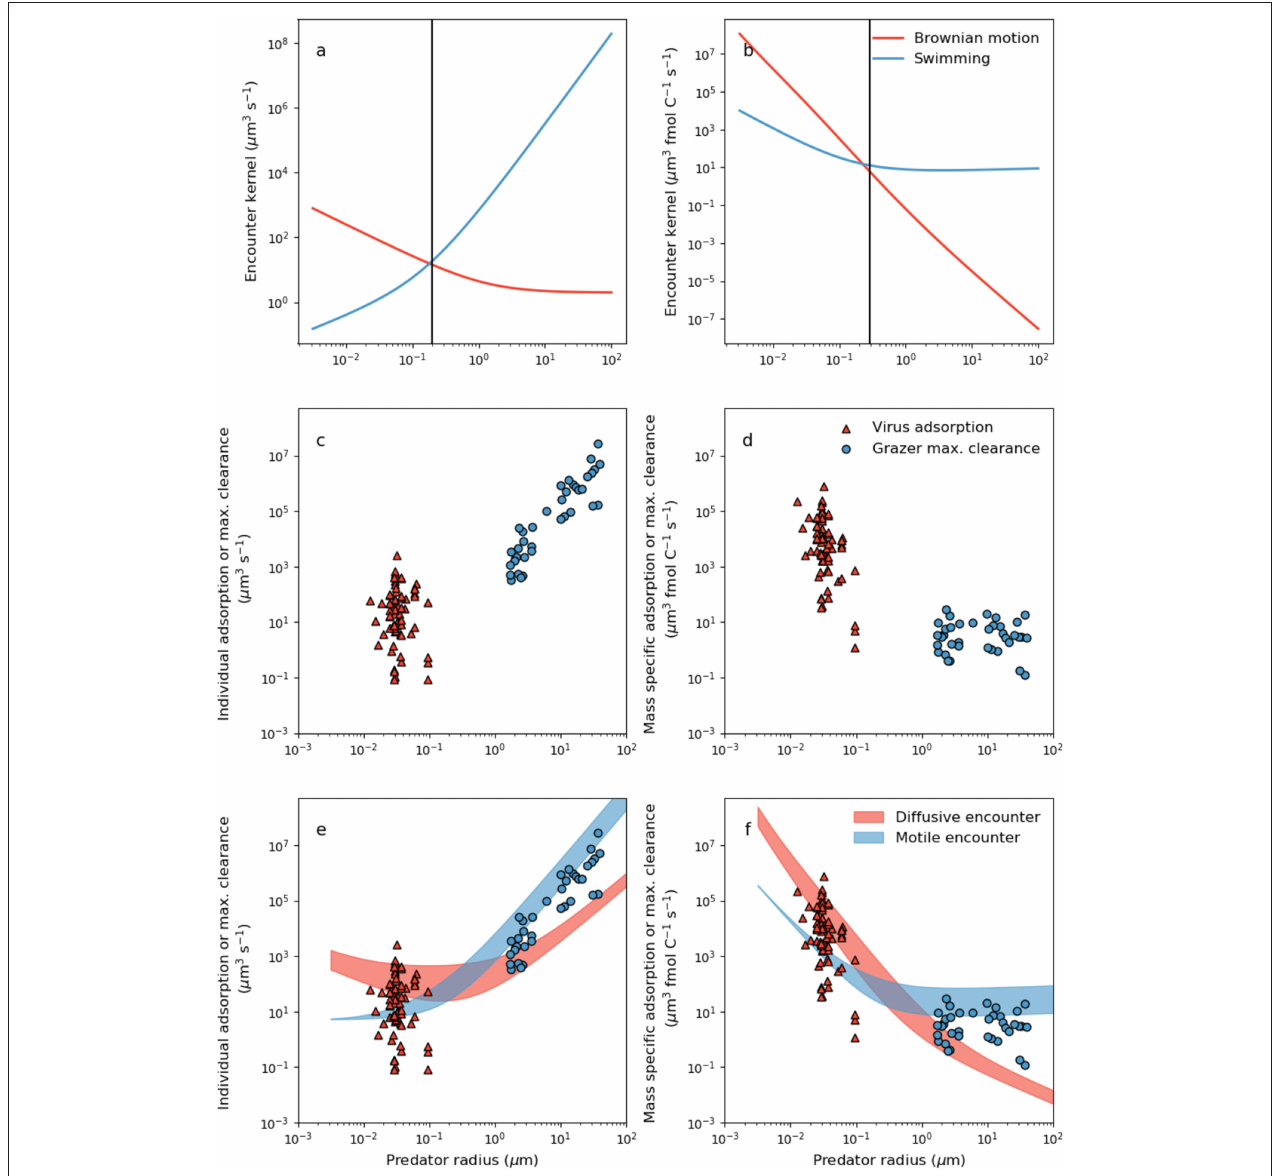
FIGURE 2 | Dependence of theoretical encounter kernel and empirical capture rate on predator size and mode of transport. (a) Per-capita theoretical encounter kernel predictions of motile predators ( ρ z ) and predators whose transport is dictated by Brownian motion ( ρ v ) using Equations 5 and 6, respectively. Prey motility was neglected by setting u prey = 0. Prey cell radius was assumed to be 1 µ m. (b) Mass specific encounter kernels ( ρ v / Q v and ρ z / Q z for diffusive and motile predators, respectively). The vertical lines in (a,b) demarcate two domains: a small size domain where predator movement by Brownian motion is most effective, and a large size domain where movement by swimming is most effective. (c) Per capita viral adsorption rates and grazer maximal clearance rates. Viral data are in Supplementary Table 1 . (d) The same data in (c) normalized per unit carbon in either the virus or the grazer (Equations 2 and 3, Table 2 ). (e) Comparison of per-capita theoretical encounter kernels with per capita capture rates. Filled regions are theoretical encounter kernels accounting for prey motion by allowing u prey to vary with predator and prey size according to the parameterizations in Table 2 . The ranges cover [0.5,5] µ m host radius (viruses only), and a 10-fold change in swimming velocity across all size ranges (grazers only) (f) Mass-specific equivalents of the relations in (e) .